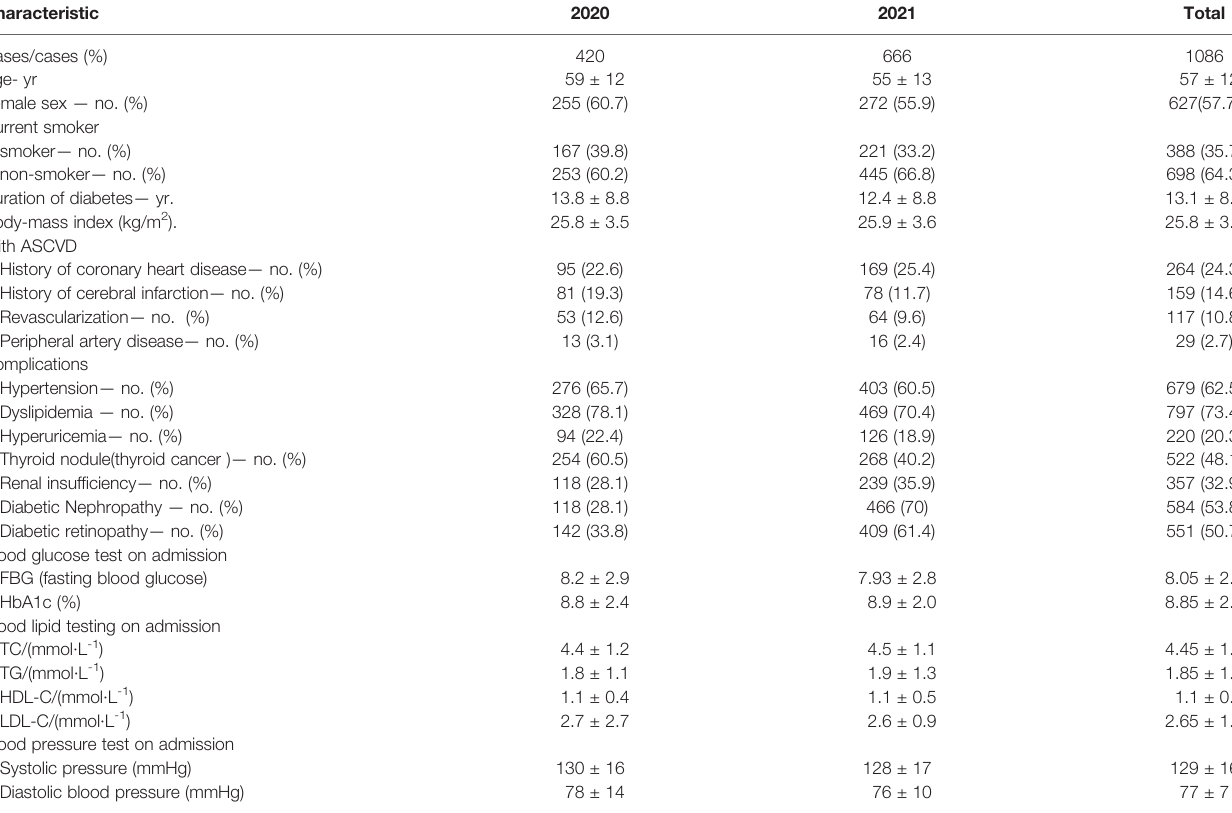
TABLE 1 | Baseline characteristics of inpatients with type 2